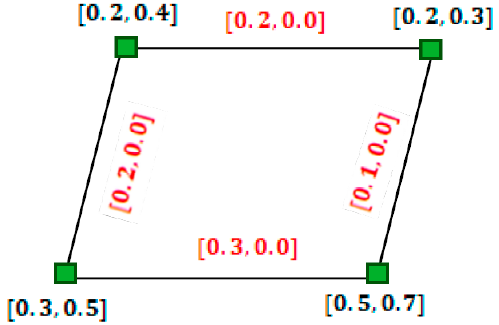
Figure 4. Interval-valued fuzzy graph containing undefined intervals.